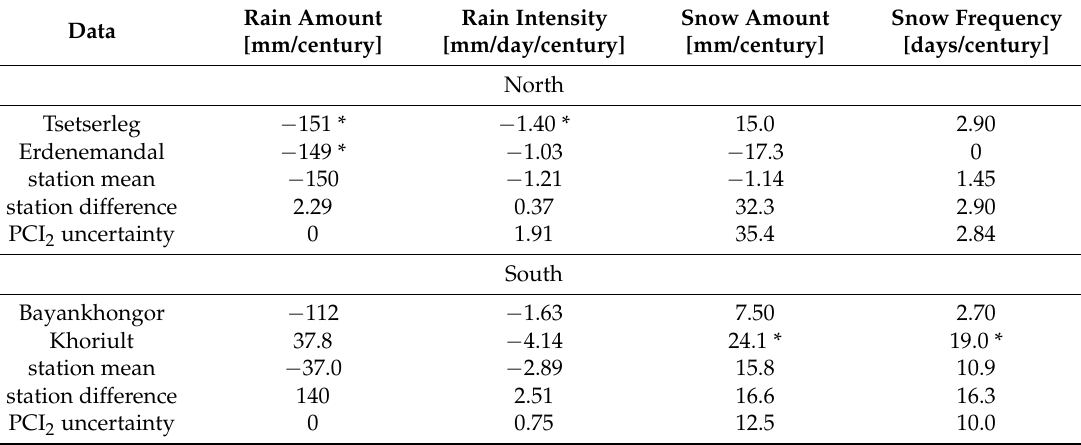
Table 2. Estimates of precipitation uncertainty for the four variables, summarizing the individual station rates of change, station mean, and difference per aimag (north and south), and herder-based uncertainty from the PCI 2 consensus scores (Figure 4), scaled to the range of precipitation values. Significant station trends at the p < 0.05 level are denoted with an asterisk.